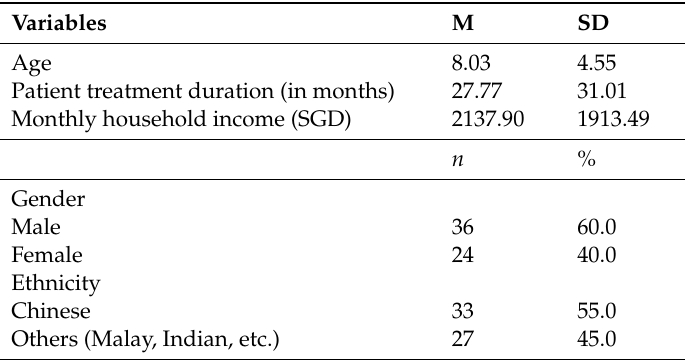
Table 1. Characteristics of the